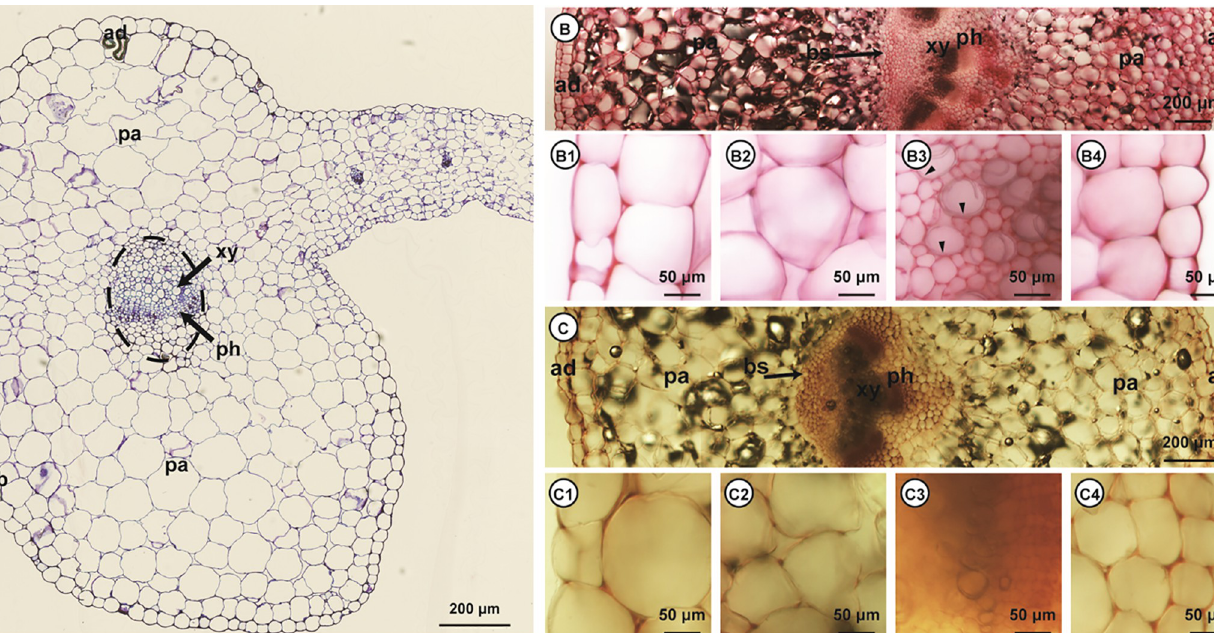
PLOS ONE | https://doi.org/10.1371/journal.pone.0207801 November20,